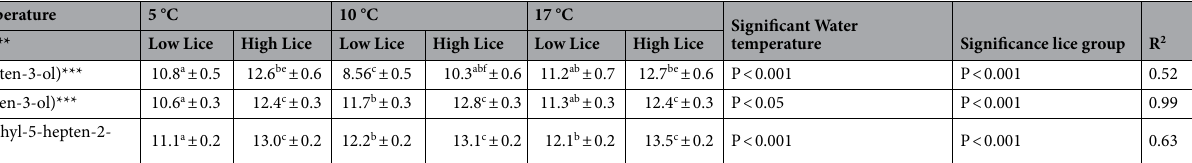
Table 1. Effects of water temperature and high or low lice group on 1-penten-3-ol, 1-octen-3-ol and 6-methyl- 5-hepten-2-one mucosal expression levels during salmon lice infection. *Different superscripts within row differ significantly at P < 0.05,** High and low lice groups correspond to the two highest and two lowest ranked fish within each tank replicated in each temperature treatment, ** VOC measured as integrated GC peak area, standard errors of estimates given after estimates ±.